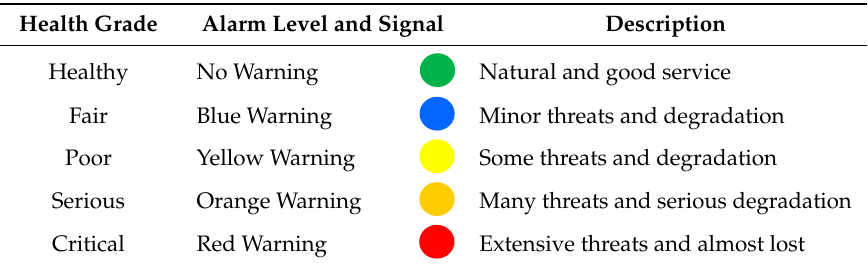
Table 1. Health grade and alarm level categories in RHP-EWS.